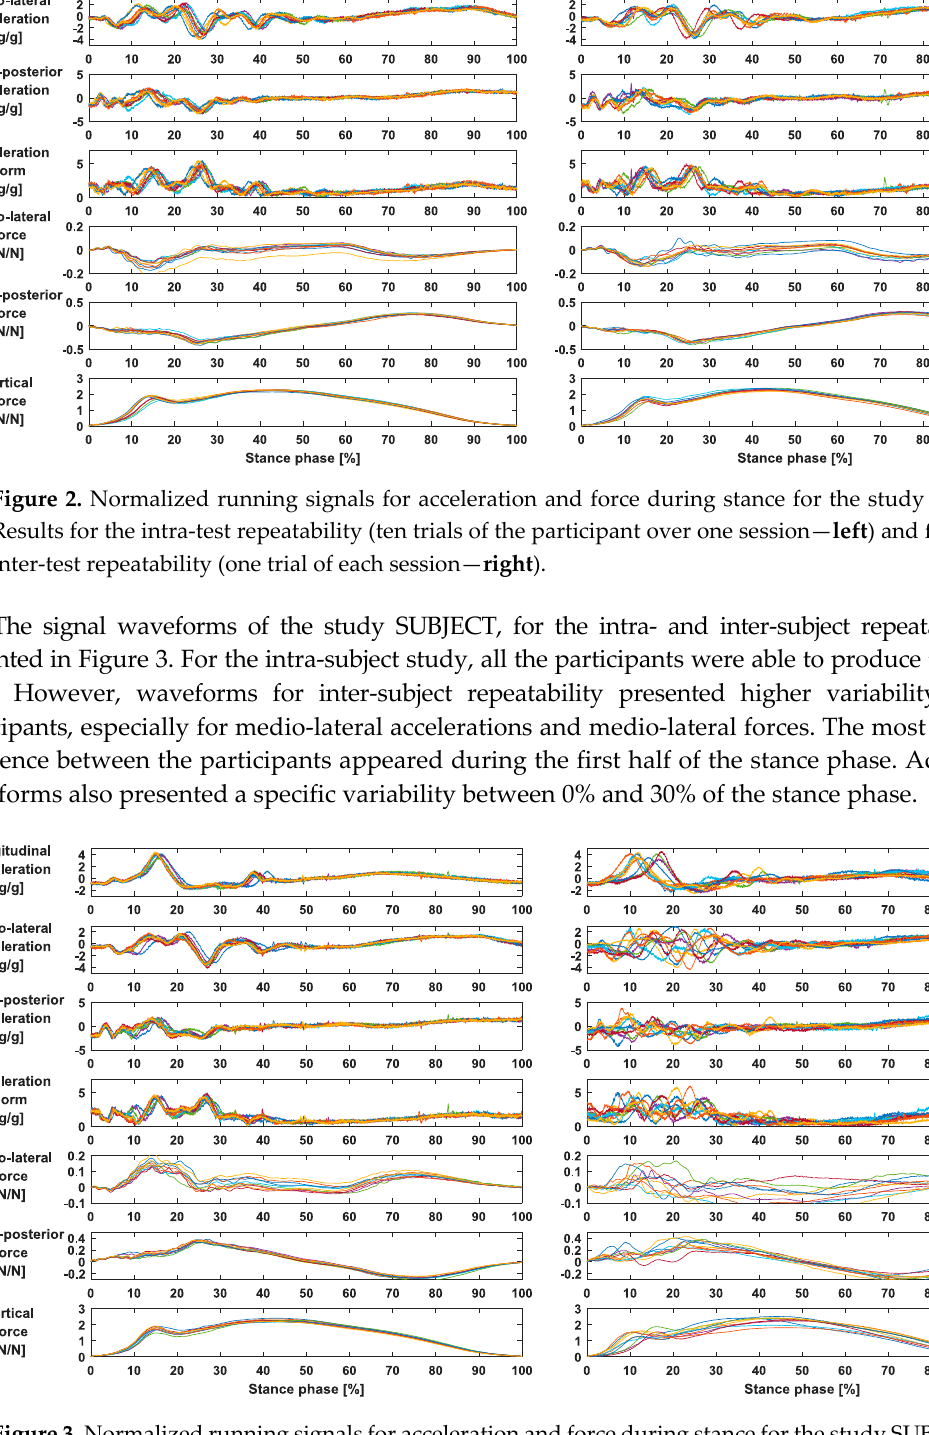
Figure 3. Normalized running signals for acceleration and force during stance for the study SUBJECT. Results for the intra-subject repeatability (ten trials of one participant— left ) and for the inter-subject repeatability (one trial of each of the ten participants— right